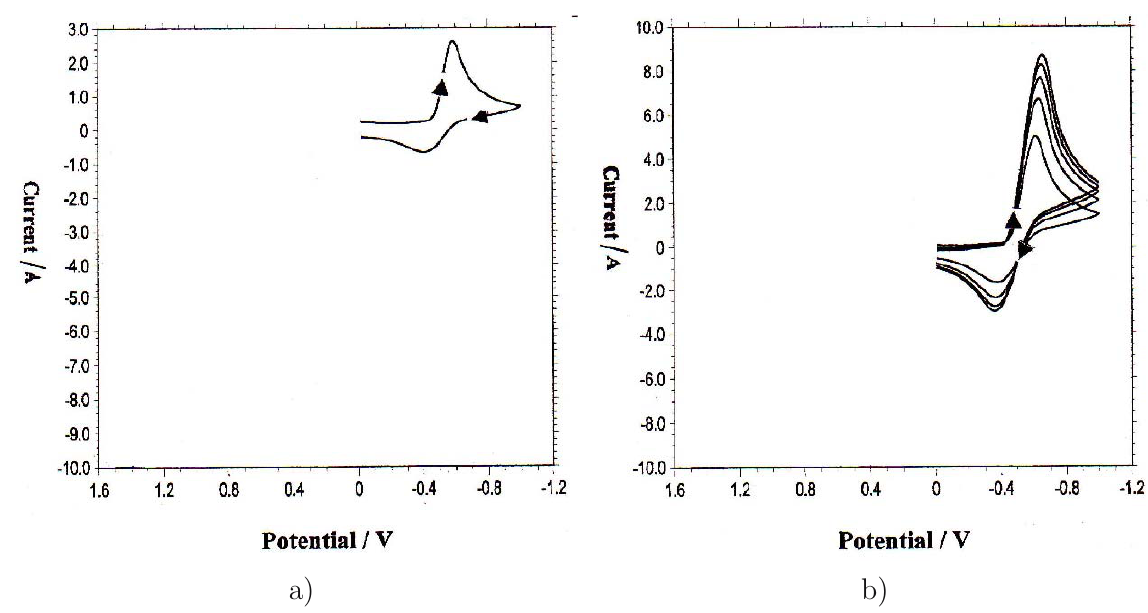
Fig. 2 Cyclic voltammogram (scan rate 0.2 Vs − 1 , DMSO, 25 ◦ , pH 7.5) of (a) complex 5 (b) complex 5 in presence of CT-DNA at different time intervals. [Complex 5 ] 1 × 10 − 3 M, [DNA] 6 × 10 − 3